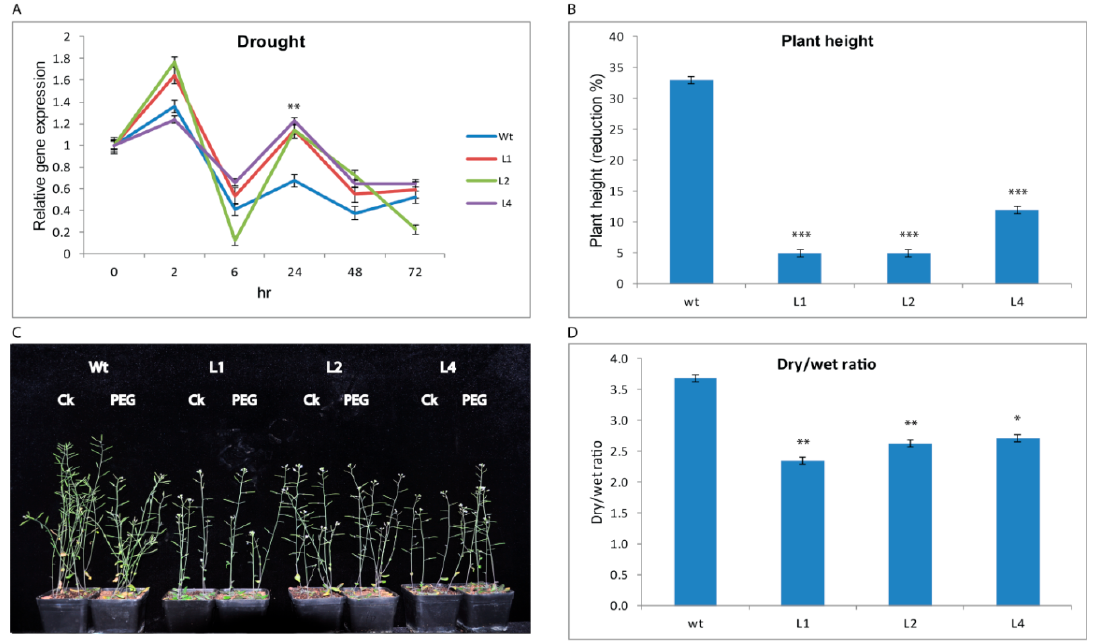
Figure 2. Overexpression of GhTRX134 in Arabidopsis enhanced drought tolerance. Two-week-old plants were treated with 20% polyethylene glycol (PEG). ( A ) The expression of GhTRX134 in transgenic lines and wild-type (Wt) under drought treatment was monitored by qRT-PCR. ( B ) Plant height was measured in centimeters (cm), and the percent reduction was calculated in transgenic lines and Wt plants under drought and control (CK) conditions. ( C ) Phenotypes of untreated (CK) transgenic and Wt plants compared with plants after drought treatment. ( D ) Di ff erences in dry / wet ratios between transgenic plants and Wt plants after PEG6000 treatment; dry / wet ratio calculated by dry weight / wet weight of plants. The data represent the means of three replicates ± SDs. Asterisks indicate significance (* p < 0.05; ** p < 0.01; and *** p < 0.001) compared to Wt as determined by Student’s t -test.